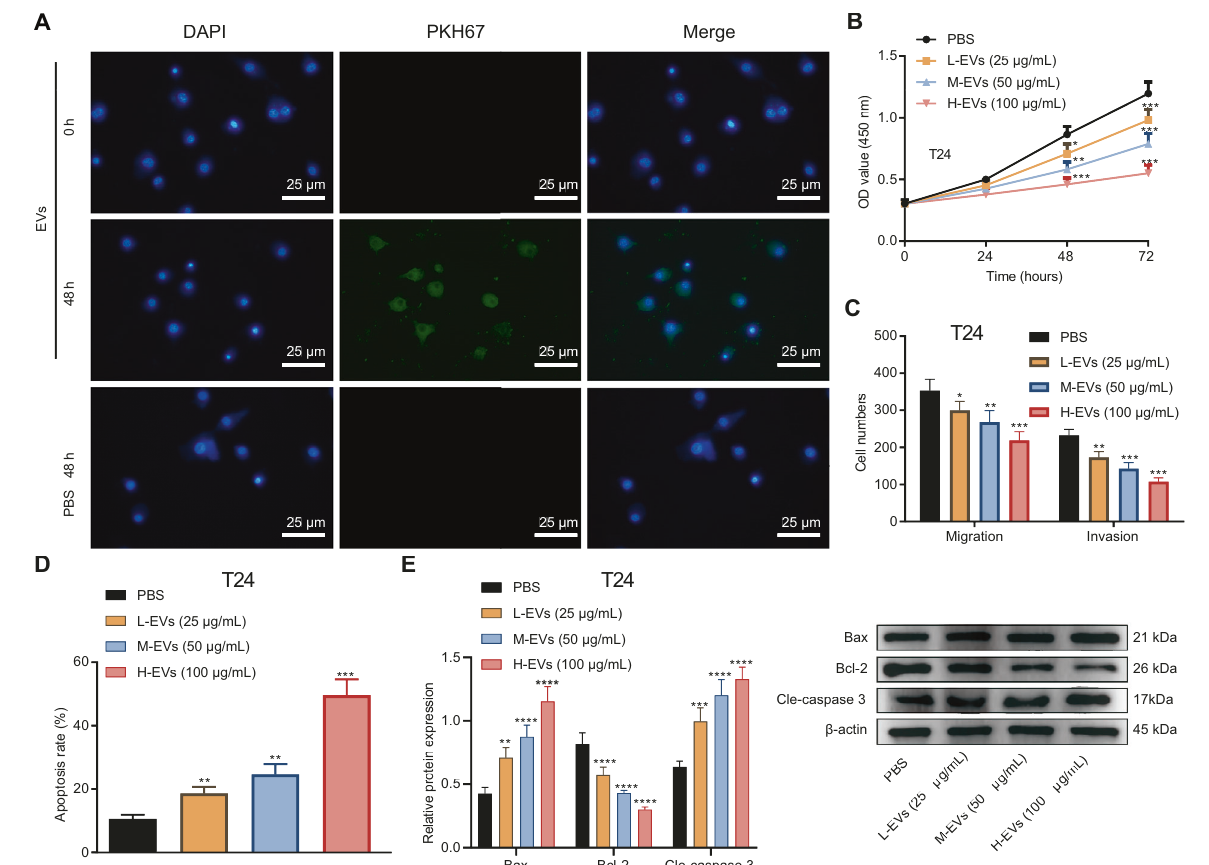
Fig. 1 BMSCs-EVs prevent the proliferation, migration, and invasion of T24 cells while inducing their apoptosis. A The uptake of EVs labeled with PKH67 (green fl uorescence) by the T24 cells analyzed using a fl uorescence microscope. DAPI stained nucleus is blue. Scale bar: 25 μ m. B The proliferation of T24 cells co-cultured with different concentrations of EVs detected by CCK-8. C The migration and invasion of T24 cells co-cultured with different concentrations of EVs detected using Transwell assay. D The apoptosis of T24 cells co-cultured with EVs with different concentrations tested using Hoechst 33342/PI staining. E The expression of apoptosis-related factors in T24 cells co-cultured with different concentrations of EVs detected using western blot analysis. Measurement data were expressed as mean ± standard deviation. Unpaired t test was performed for two-group data comparison. * p < 0.05, ** p < 0.01, *** p < 0.001 or **** p < 0.0001, vs. PBS-treated T24 cells. The cell experiment was repeated three times independently. demonstrated a progressive increase in the apoptosis of T24 and BOY-12E cells (Fig. 1D, Supplementary Fig. 2D), accompanied by decreased protein expression of Bcl-2 (Fig. 1E, Supplementary Fig. 2E) and elevated protein expression of Bax and Cle-caspase 3 (Fig. 1E, Supplementary Fig. 2E) as the concentration of EVs increased. To sum up, BMSCs-EVs can inhibit the malignant features of bladder cancer cells. BMSCs-EVs transfer miR-139-5p into bladder cancer cells Differential analysis of the bladder cancer-related miRNA expres- sion dataset GSE40355 revealed 15 signi fi cantly upregulated and 39 signi fi cantly downregulated in the bladder cancer samples (Fig. 2A). The R language “ pheatmap ” package was processed to visualize these miRNAs in bladder cancer tissues (Fig. 2B). The miRNAs expressed in the BMSCs-EVs were obtained using EVmiRNA database, of which the fi rst 150 miRNAs were intersected with the fi rst 10 miRNAs signi fi cantly downregulated in the bladder cancer samples in the GSE40355 dataset, with miR-139-5p found at the intersection (Fig. 2C). A previous study has shown a reduction in miR-139-5p expression in bladder cancer [11]. Therefore, miR- 139-5p was selected as the target for the subsequent assay. A decline of miR-139-5p was found in bladder cancer tissues (Fig. 2D). Kaplan – Meier curve analysis results suggested that the